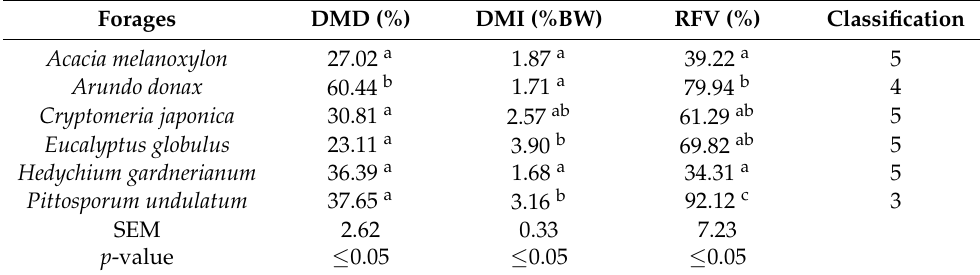
Table 2. Relative feed values and qualities of the unconventional forages. Forages DMD (%) DMI (%BW) RFV